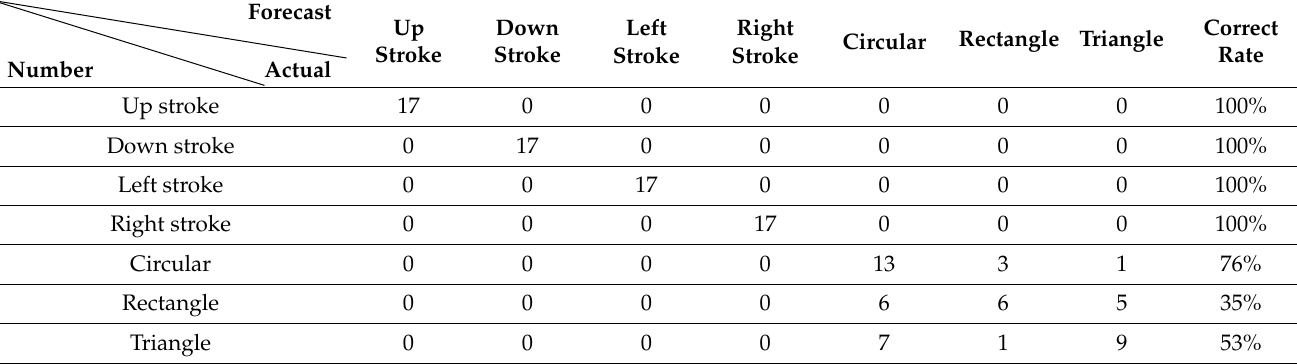
Table 2. Effective identification of different dynamic